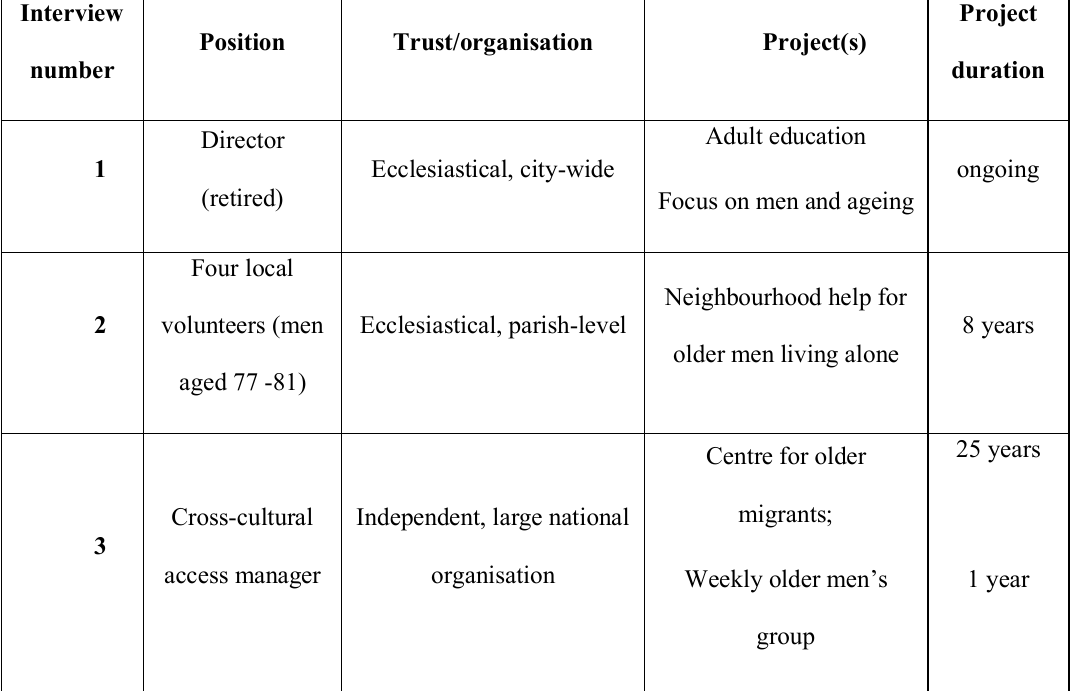
Table 1: Sample of stakeholders